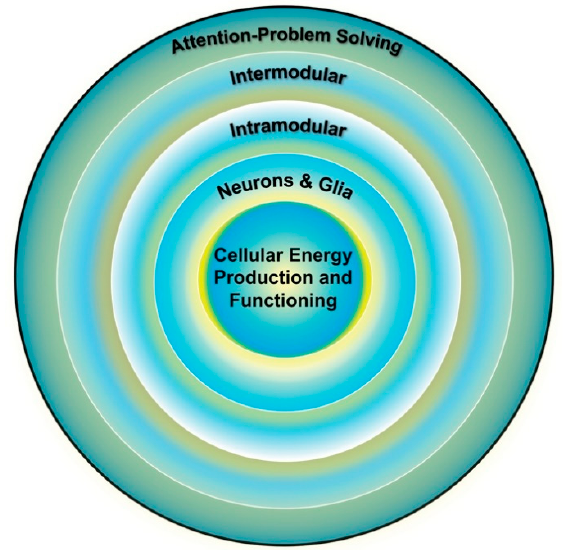
Figure 3. Individual differences in cognition (outer ring) are influenced by the functioning of multiple brain systems, the optimal functioning of which is dependent on the efficiency of the systems below it. Cellular energy is the lowest common currency driving the development and expression of all biological systems and thus places upper-limit constraints on the development and expression of all other systems, including cognition. Adapted from Geary [29] (p. 4).